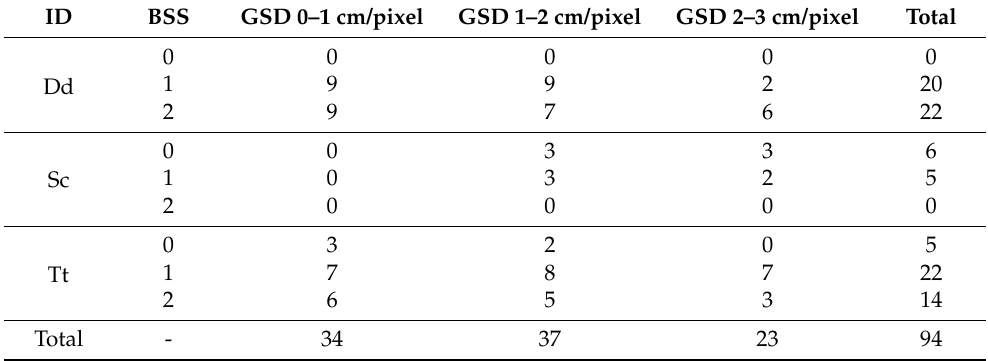
Table 1. Number of images by ground sample distance (GSD), Beaufort sea state (BSS) and true species identity (ID; Dd = Delphinus delphis ; Sc = Stenella coeruleoalba ; Tt = Tursiops truncatus ). ID BSS GSD 0–1 cm/pixel